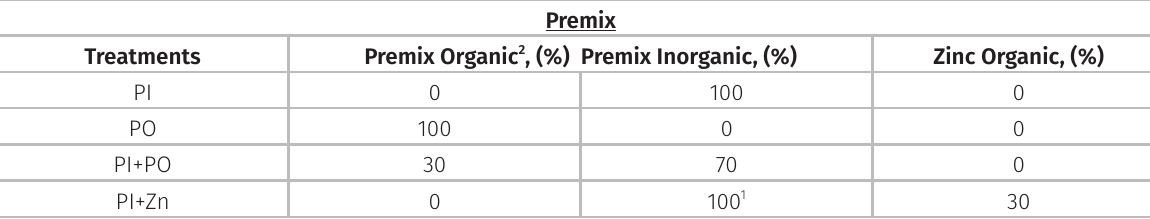
Table I. Treatments involving broiler breeders and different minerals. Premix Treatments Premix Organic 2 , (%) Premix Inorganic, (%) Zinc Organic, (%) PI 0 100 0 PO 100 0 0 PI+PO 30 70 0 PI+Zn 0 100 1 30 1 Except for Zinc, that is 70%. PI= 100% premix mineral inorganic: Cu, 300mg; Fe, 1500mg; Mg 2100mg; Se, 9mg; Zn, 1950mg per kg of diet. PO= 100% premix mineral organic: Cu, 500mg; Fe, 3500mg; Mg 4000mg; Se, 16mg; Zn, 5500mg per kg of diet. PI+PO= 70% premix mineral inorganic (Cu, 210mg; Fe, 1.050mg; Mg 1.470mg; Se, 6.3mg; Zn, 1.365mg per kg of diet). + 30% premix mineral organic (Cu, 150mg; Fe, 1050mg; Mg 1200mg; Se, 4.8mg; Zn, 1650mg per kg of